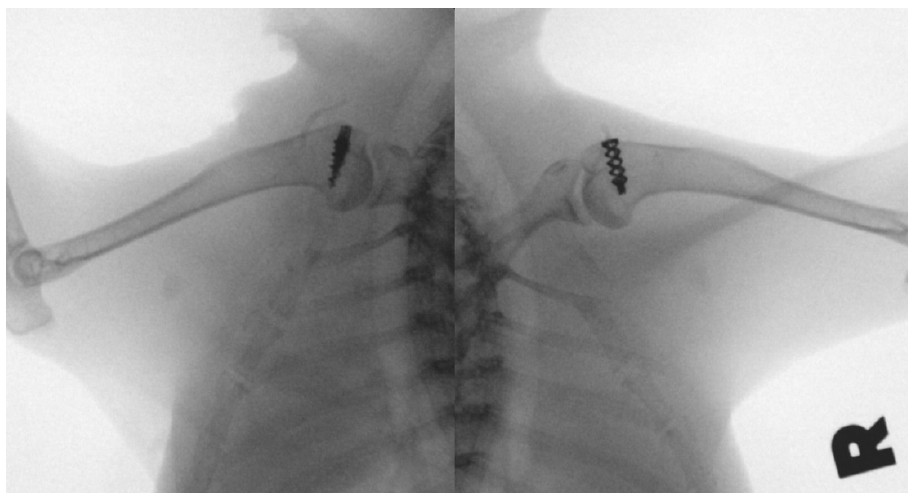
Figure 4. The radiograph shows that the Ti SA (left shoulder) and Fe SA (right shoulder) were inserted into the proximal humerus greater tuberosity.